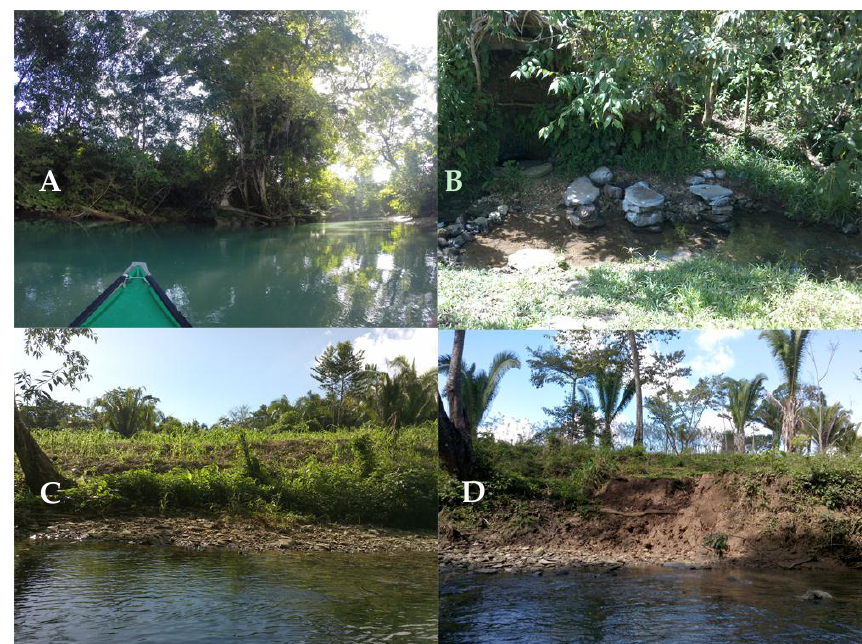
Figure 7. Photographic examples of thin riparian buffer ( A ), laundry sites ( B ), no riparian buffer ( C ), and no riparian buffer with livestock access ( D ).